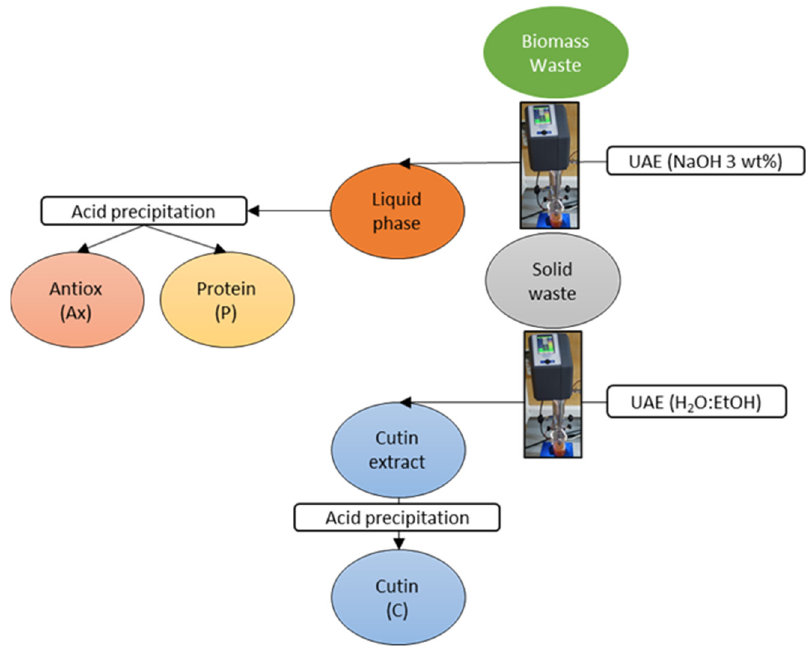
Figure 1. Scheme of the cascade approach process followed in this work for different biomass